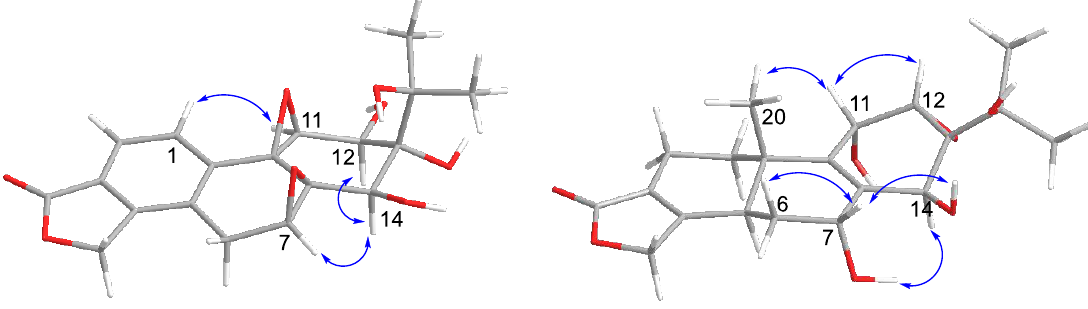
Figure 5. Key NOESY correlations of compounds 2 and 3 .